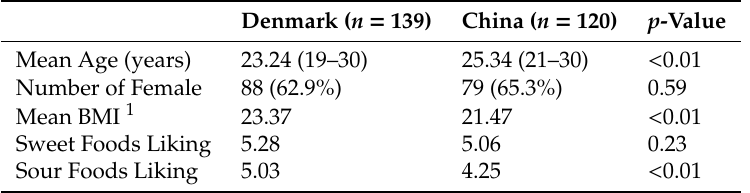
Table 2. Baseline characteristics of Danish and Chinese consumers. Provided p -values of Student’s t -test for di ff erence between Danish and Chinese consumer groups. The age range is presented